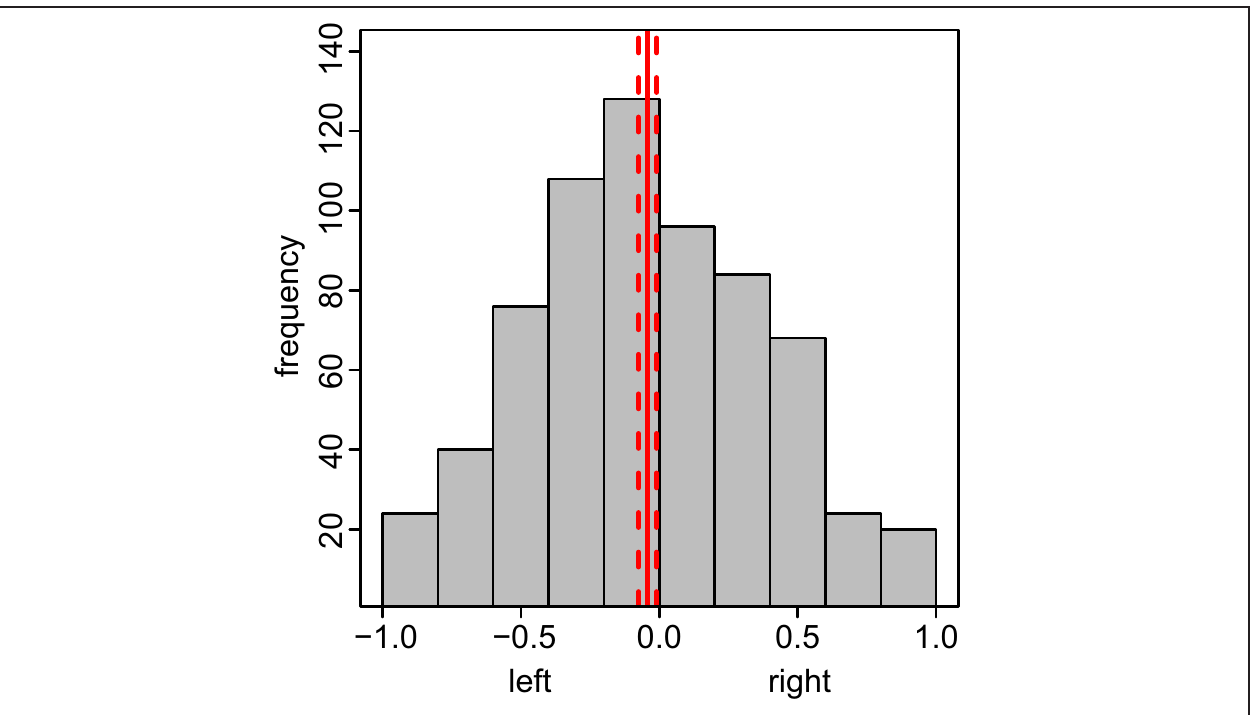
Indices calculated by taking the relative ratio between integrals of negative (left side movement) and positive (right side movement) positions over time for each bee ( N = 174). The total test phase was used. Solid red line indicates the mean side preference; the dashed lines indicate 95% confidence interval.